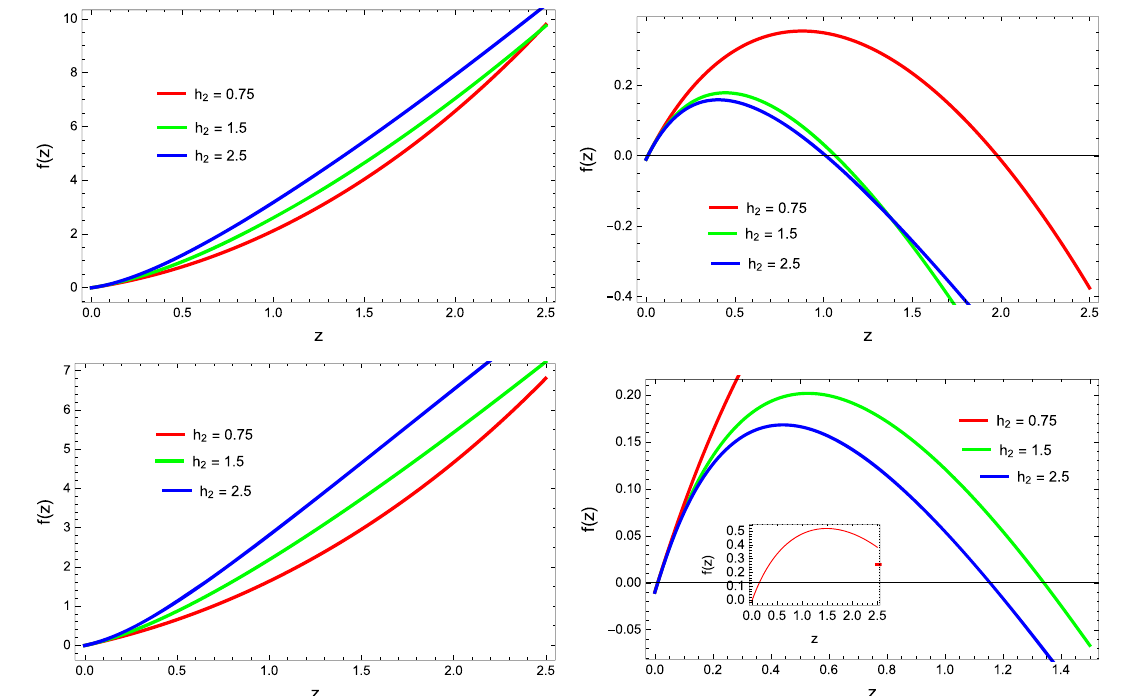
Fig. 8 Plots of unified phase reconstructed GGPDE f ( R ) model for k = 1 (upper panel) and k = − 1 (lower panel) with η = 0 . 99 and η = − 0 . 99